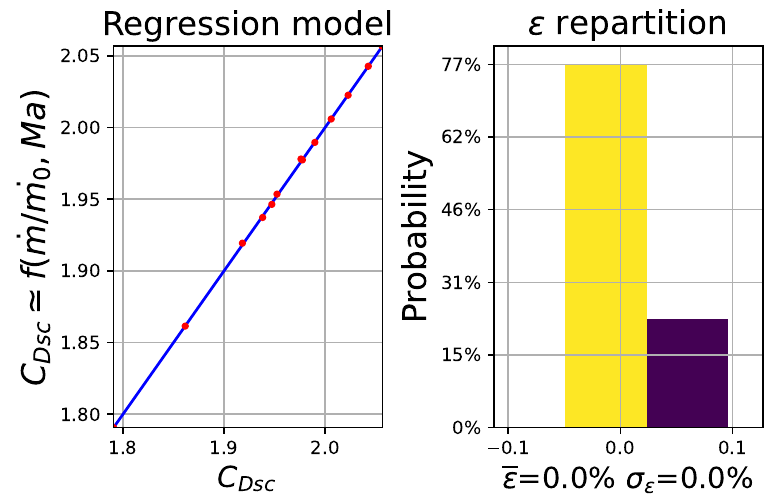
Figure 7. Output of regression model performed on C Dsc —validation and error